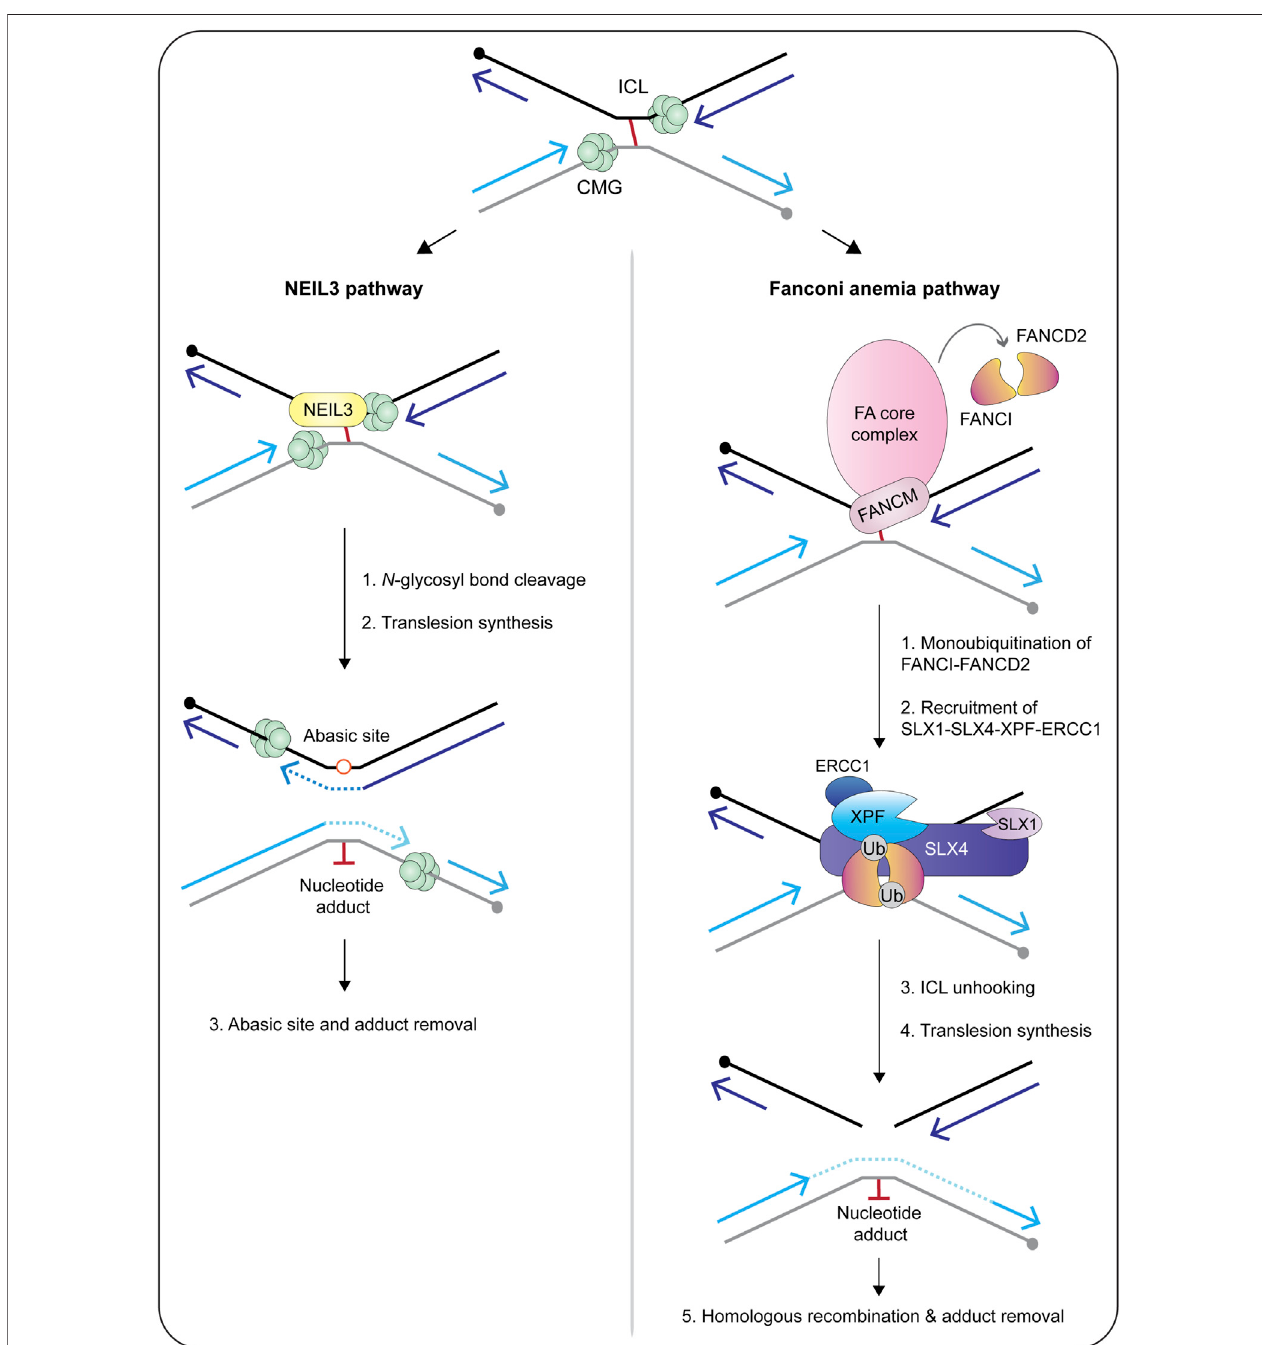
FIGURE 7 | Current models of replication-coupled ICL repair by the NEIL3 glycosylase (left) and Fanconi anemia (right) pathways. Repair is activated when replisomes converge at the ICL. The NEIL3 pathway is preferentially activated by abasic and psoralen-induced crosslinks, whereas the Fanconi anemia pathway is activated by lesions caused by cisplatin, mitomycin C and acetaldehyde. In the NEIL3 pathway, one of the two N -glycosyl bonds that form the ICL are cleaved by the NEIL3 glycosylase, unhooking the crosslink without generating a double-strand break. This reaction does not require CMG unloading or FANCI-FANCD2. After unhooking,thegapsare fi lledinviatranslesionsynthesispolymerases.IftheNEIL3pathwayfailsorthereplisomesconvergeatacisplatin-inducedcrosslink,theFanconi anemia pathway is activated and repairs the lesion via dual incisions in the phosphodiester backbone. This reaction requires unloading of the CMG helicase and activation of the Fanconi anemia core complex. The core complex catalyzes the monoubiquitination of FANCI-FANCD2, causing it to clamp around double-stranded DNA. This is thought to trigger the recruitment of SLX4 and its associated endonucleases to execute crosslink unhooking via dual incisions in the phosphodiester backbone. The resulting double-strand break is repaired through the actions of translesion synthesis polymerases and homologous recombination. In both pathways, the nucleotide adduct is removed by nucleotide excision repair. Circles indicate 5 ′ -termini. Arrowheads on nascent DNA indicate 3 ′ -termini. Abbreviations: ICL, interstrand crosslink; Ub,